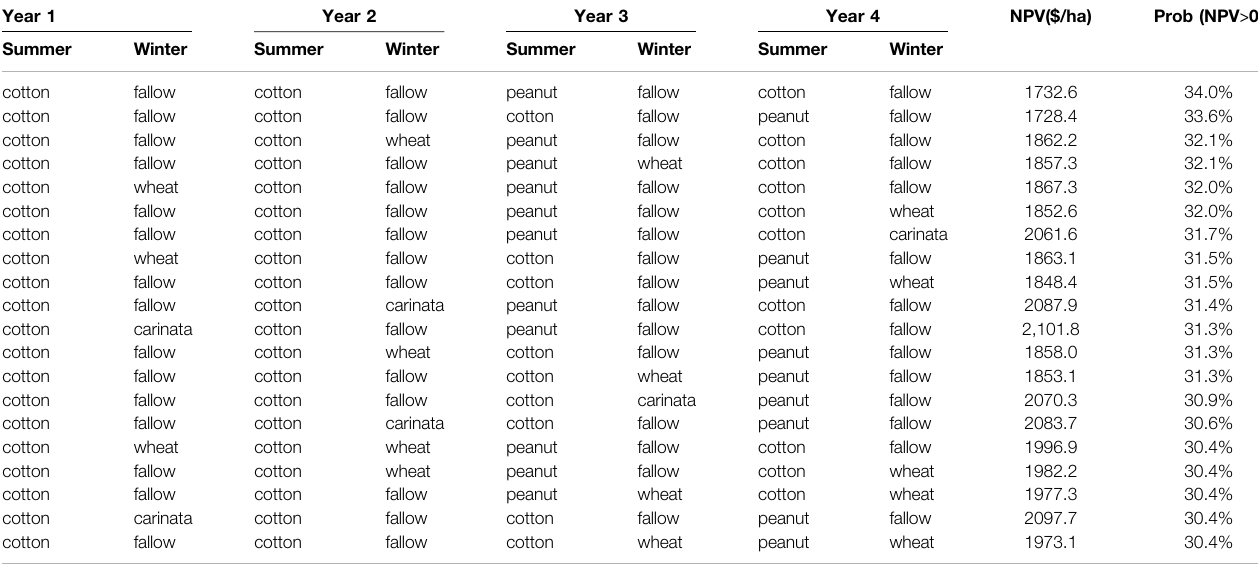
TABLE 6 | Top 20 rotations under S1 with the highest probability of positive NPV.